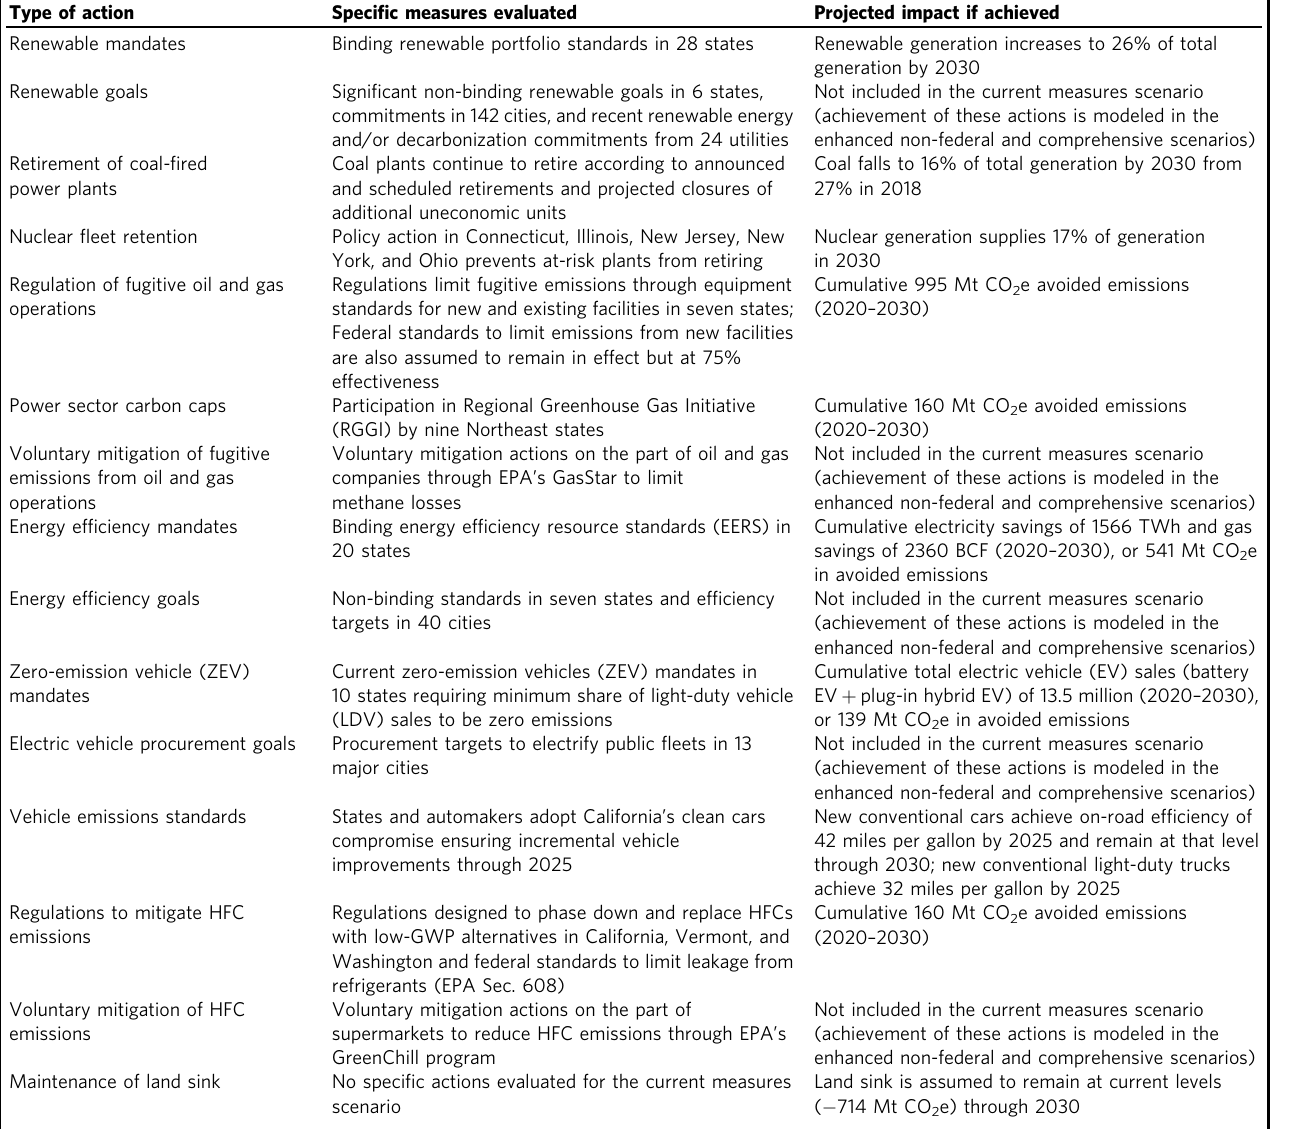
Table 1 Overview of measures evaluated for the U.S. current measures scenario (left) and impact in 2030